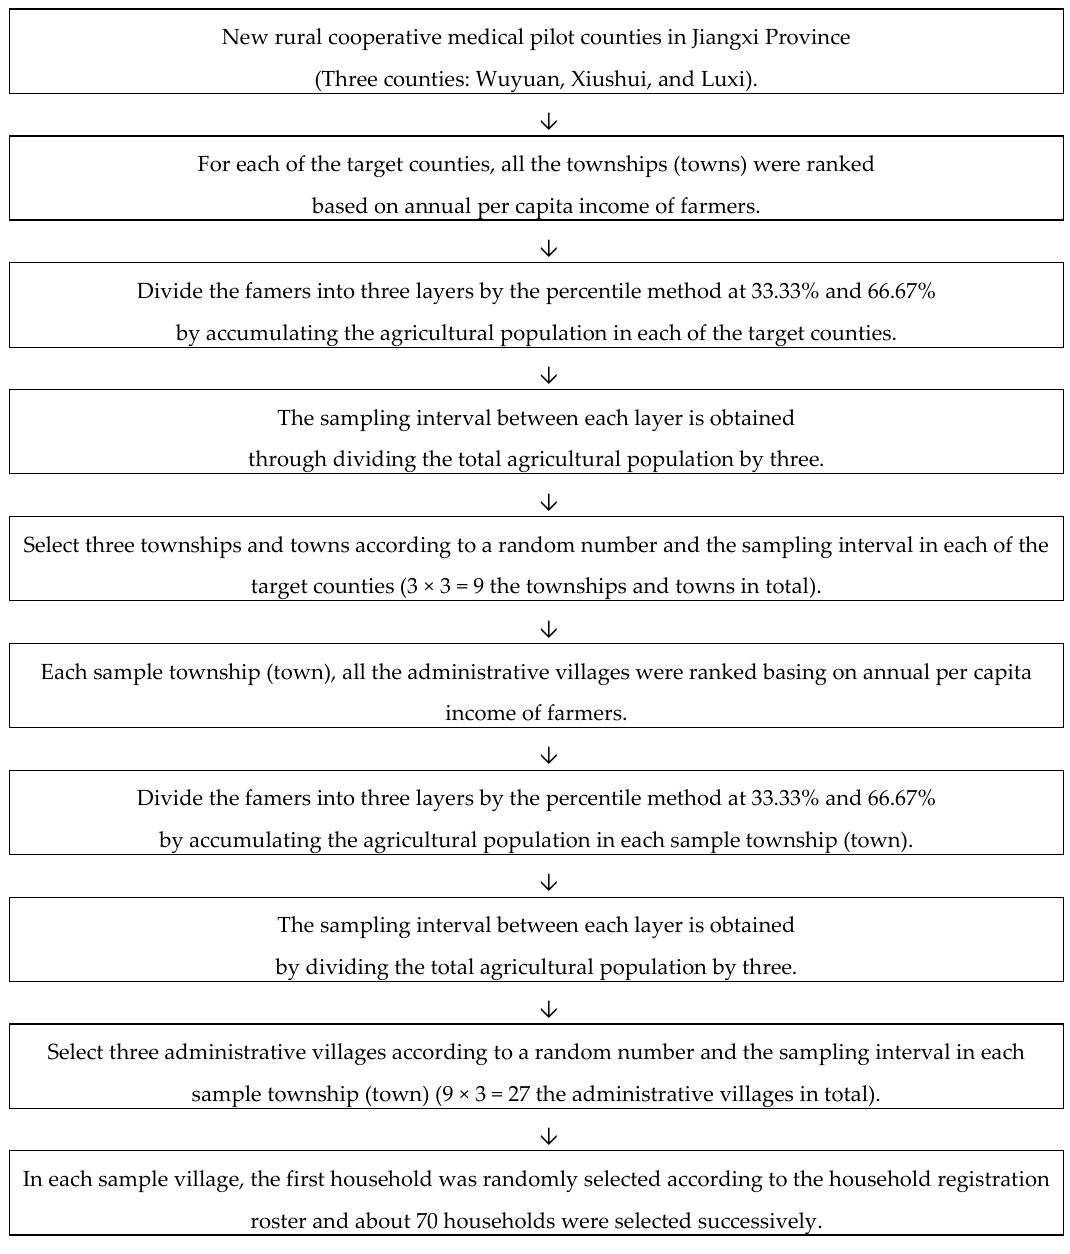
Figure 1. The sampling process.